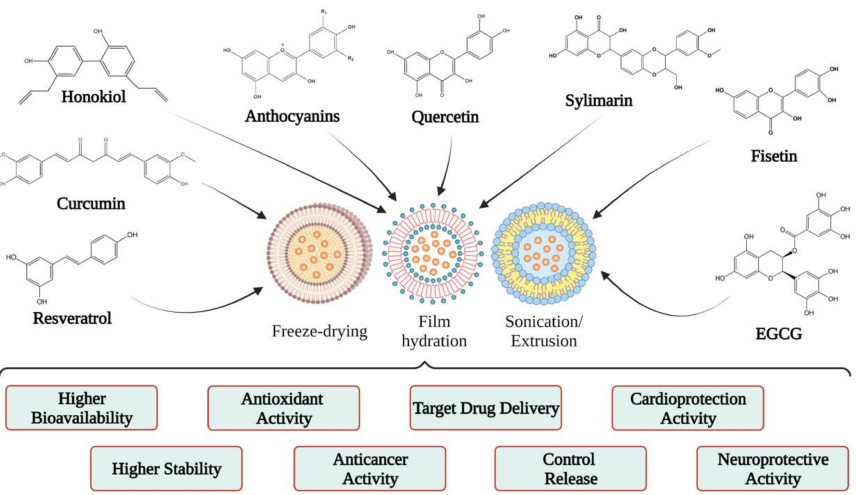
Figure 4. Examples of liposomal forms developed for polyphenol biological